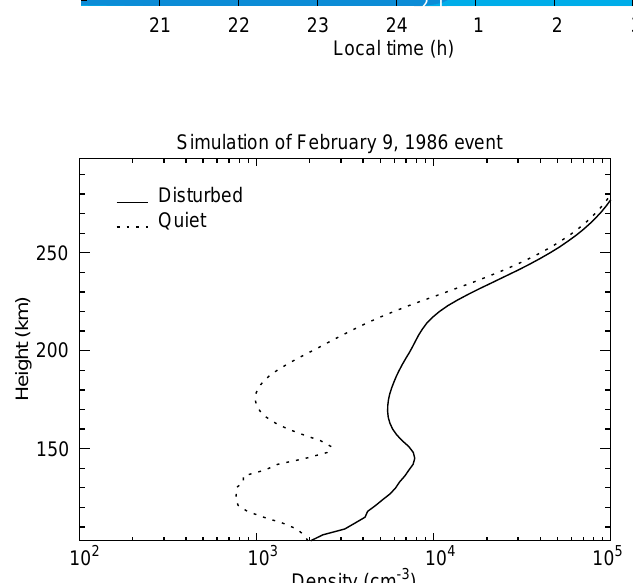
Fig. 7. Contour plots of the electron densities obtained in the simulations for April 20, 1985. A tidal layer moves from an altitude of 180 km downward to an altitude of 115 km. The density of this layer is enhanced due to the additional ionization production by precipitated ring current particles. Also the valley between this layer and the lower F- region is filled in by this additional ionization